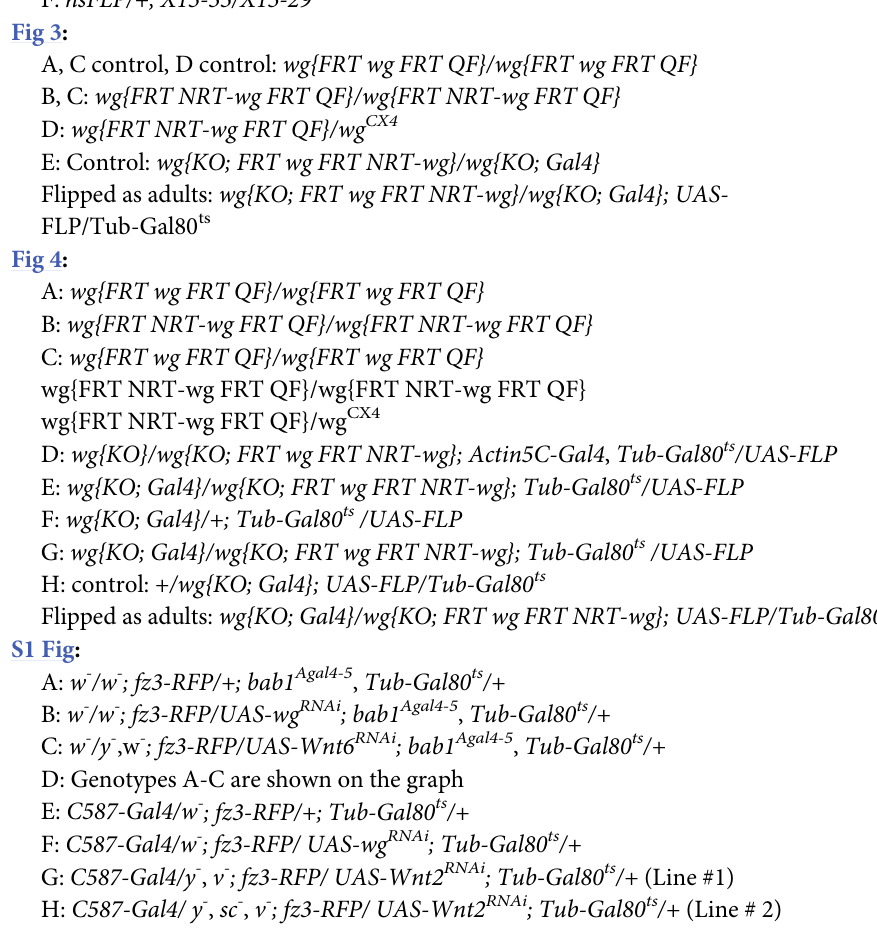
Fig 2: A left, B, and G: wg{FRT wg FRT QF}/wg{FRT wg FRT QF} A middle, C, and H: wg{FRT NRT-wg FRT QF}/wg{FRT NRT-wg FRT QF} A right, D, and E: wg{FRT NRT-wg FRT QF}/wg CX4 F: hsFLP/+; X15-33/X15-29 Fig 3: A, C control, D control: wg{FRT wg FRT QF}/wg{FRT wg FRT QF}